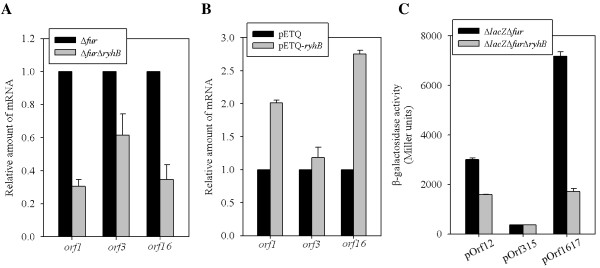
RyhB activates the transcriptional level of theorf1andorf16. (A) qRT-PCR analyses of the expression of the K2 cps genes (orf1, orf3, and orf16) were measured in Δfur and ΔfurΔryhB strains. (B) WT strain carrying the IPTG inducible vector pETQ and pETQ-ryhB in response to 100 μM IPTG. (C) The β-galactosidase activities of K. pneumoniae CG43S3ΔlacZΔfur and ΔlacZΔfurΔryhB carrying the reporter plasmid pOrf12 (Porf1-2::lacZ), pOrf315 (Porf3-15::lacZ) or pOrf1617 (Porf16-17::lacZ) were determined using log-phased cultures grown in LB broth. The results shown are an average of triplicate samples. Error bars indicate standard deviations.